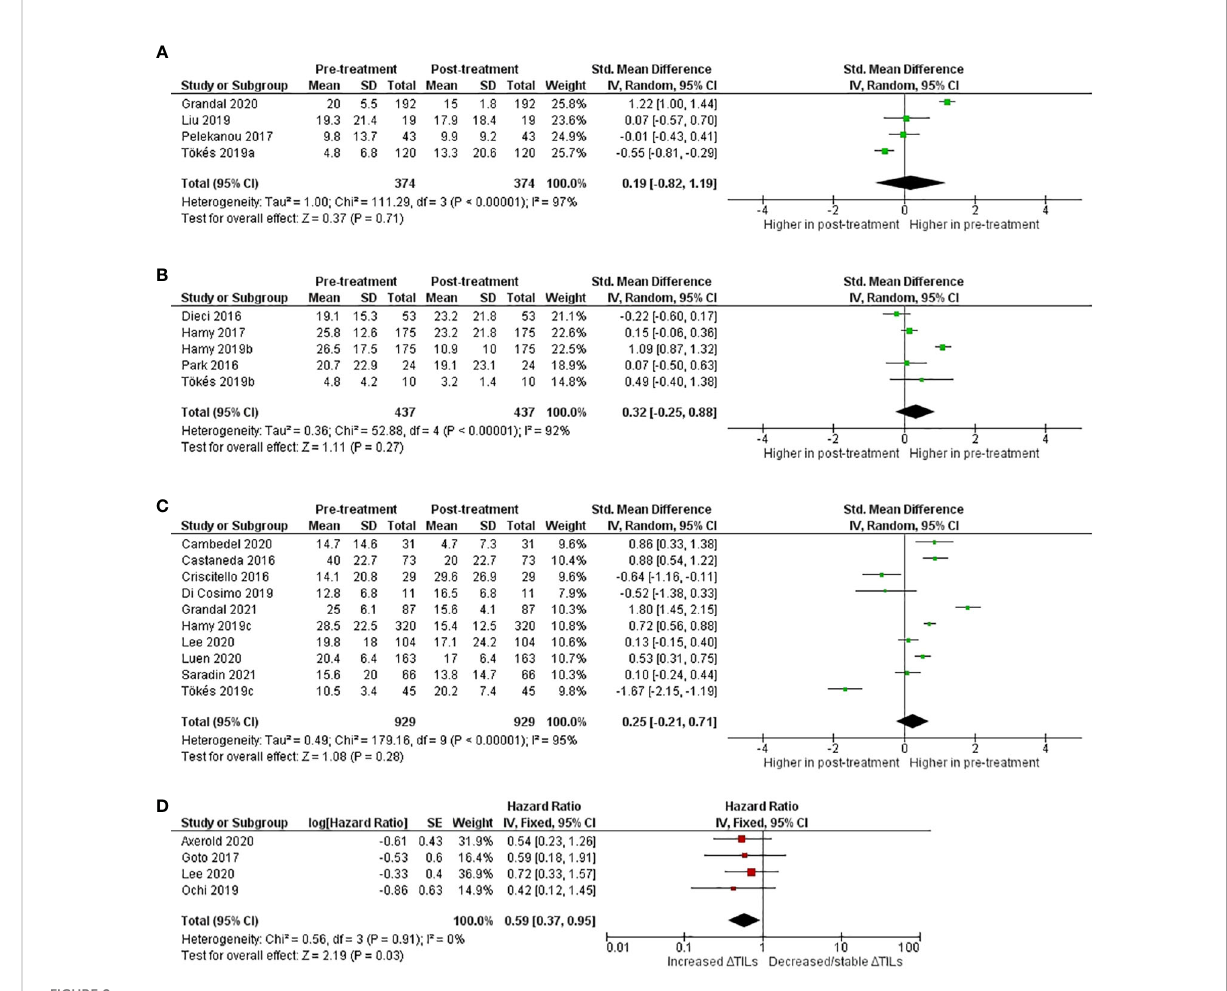
FIGURE 2 Forest-plots on Standardized mean difference (SMD) of Tumor-In fi ltrating Lymphocytes (TILs) pre- and post-treatment per breast cancer subtype (A) not speci fi ed (B) HER2-positive (C) Triple-negative breast cancer [TNBC] and (D) Disease-free survival [DFS]/Recurrence-free survival [RFS] according to TILs change in TNBC